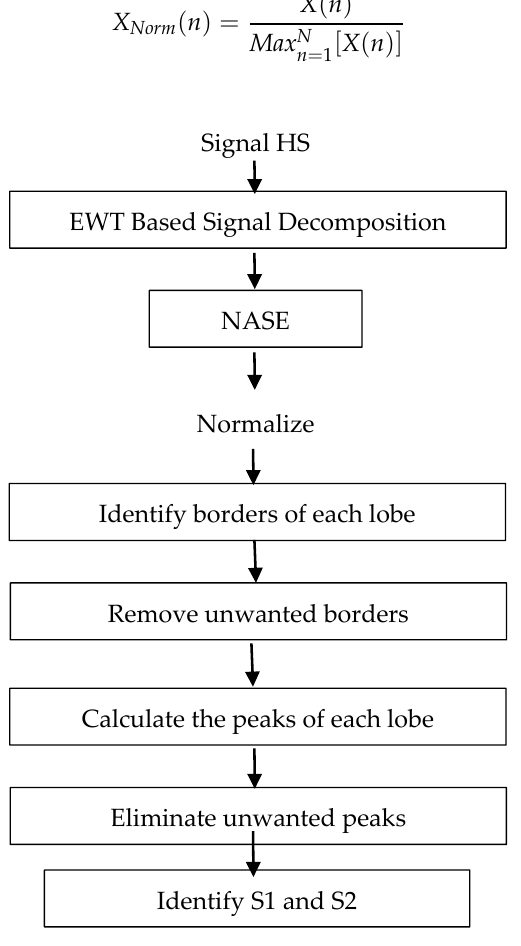
Figure 1. Block diagram for the proposed segmentation system. 218